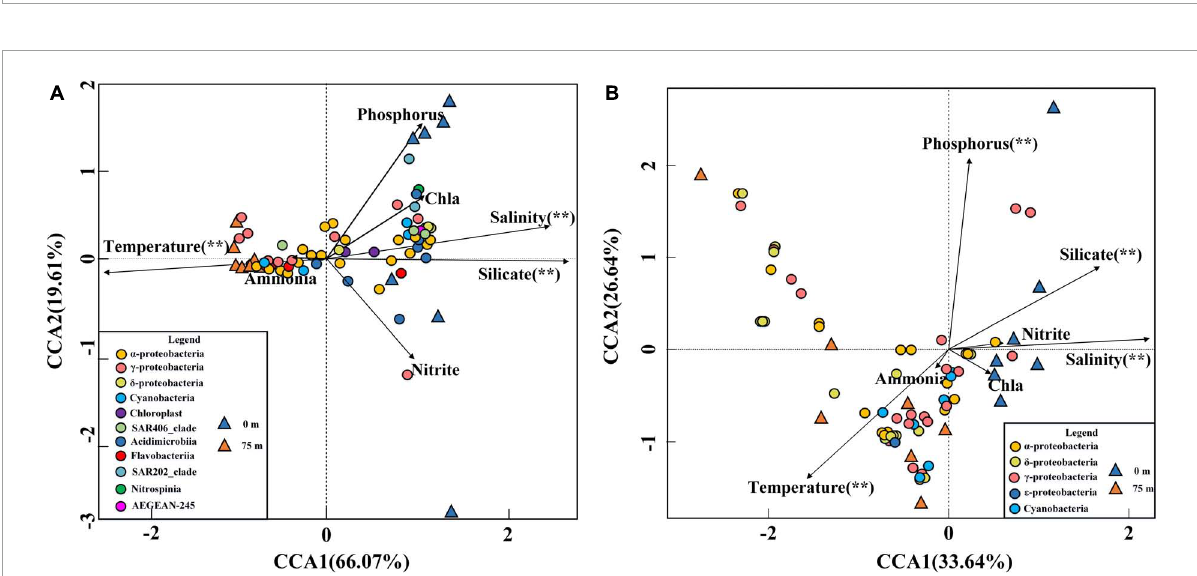
FIGURE8 CCA for the relationship between the 16S rRNA gene (A) and nif H gene (B) distributions with the environmental parameters in the BoB. Black arrows represented environmental parameters and different colored triangles represented different layer samples. Significant (**) was determined by 999 Monte Carlo permutation tests in R V.3.0